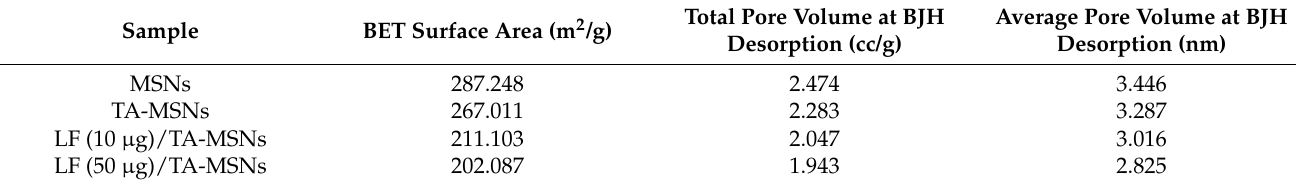
Table 2. Adsorption and desorption parameters of all MSN groups.